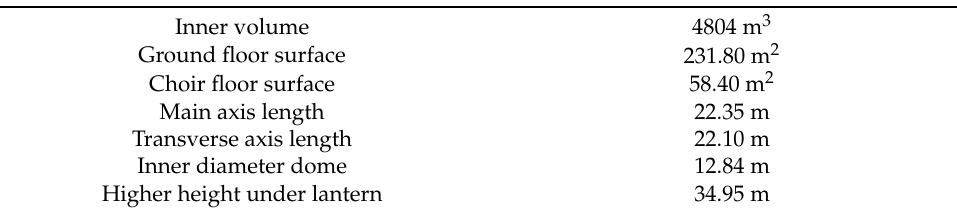
Table 1. Main geometric